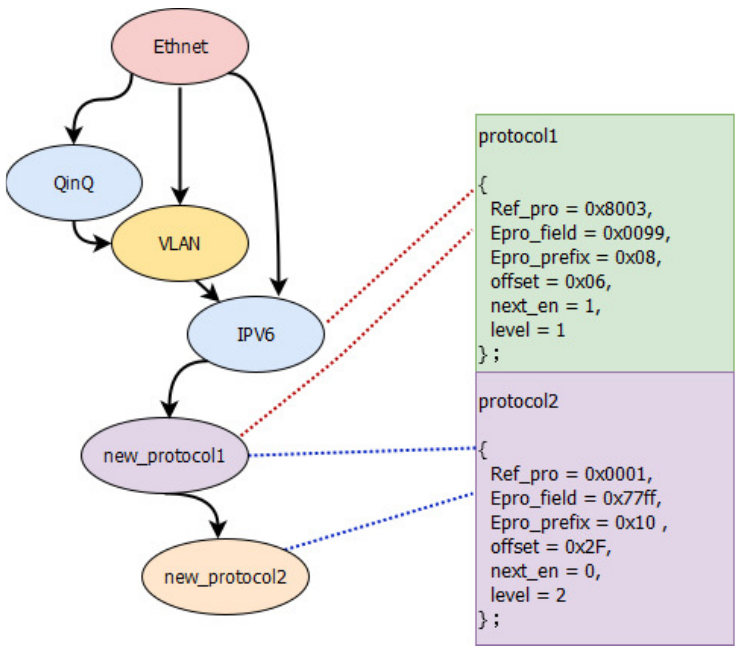
Figure 2. Protocol extension